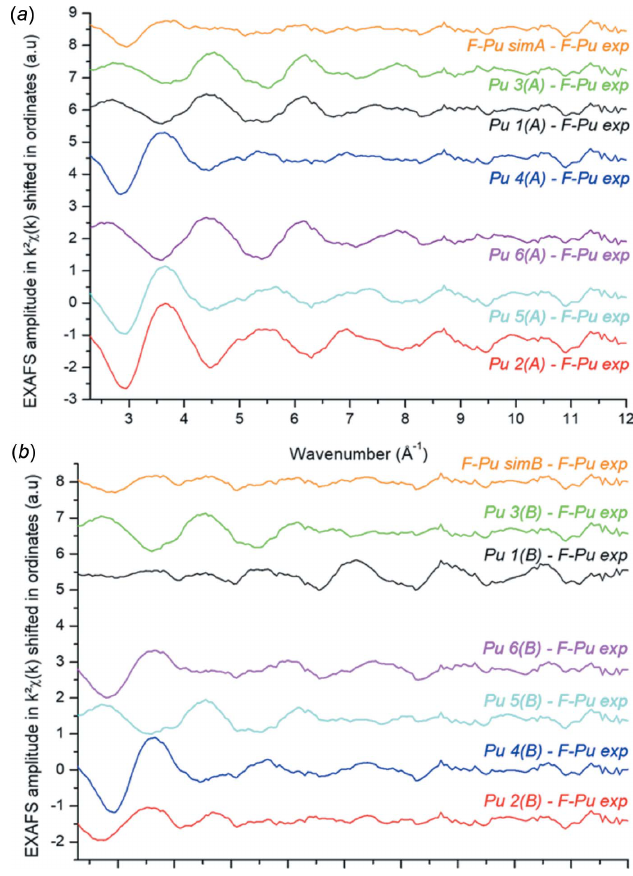
Figure 2 Difference EXAFS spectra (cid:2) dif in k 2 (cid:2) ( k ) for ( a ) simulation A and ( b ) simulation B according to the formula: (cid:2) dif(average) = {F-Pu-sim(A,B) (cid:2) F- Pu-exp}, (cid:2) dif(Pu) = {Pu-i(A,B) (cid:2) or Pu1(B) sites may be chosen as model sites, as mentioned previously. {Pu3(B) (cid:2) F-Pu-exp} shows smaller amplitudes after k = 5 A˚ (cid:2) 1 than {Pu1(B) (cid:2) F-Pu-exp}, justifying the